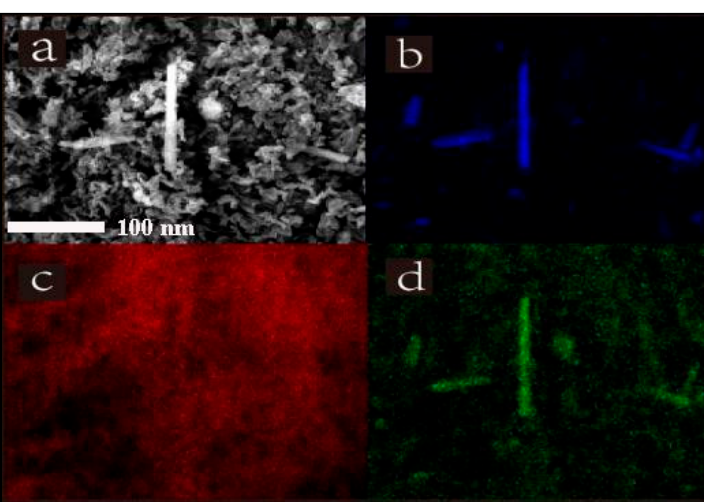
Figure 5. SEM image of the PLLA1 ( a ) and element distribution (( b ) oxygen, ( c ) carbon, ( d ) magnesium).